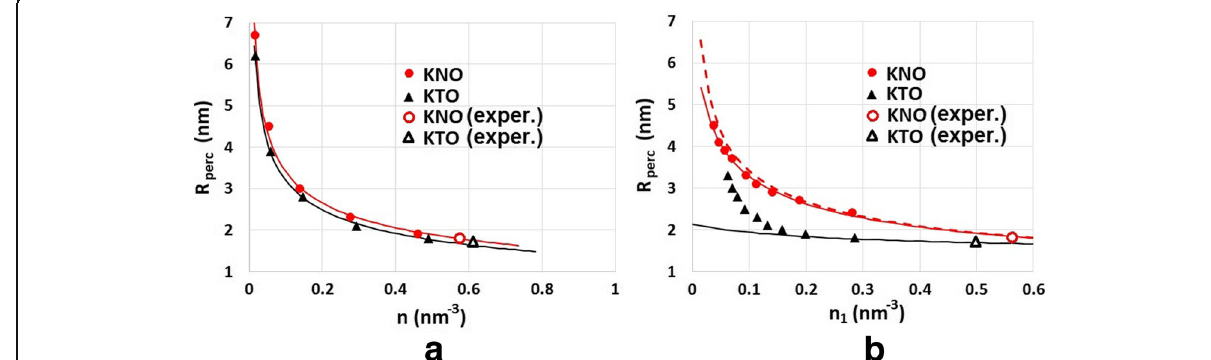
Fig. 9 Percolation radius versus the concentration of defects for two cases: a n 1 / n 2 =const, n varies and b n 2 =const, n 1 varies. Points are calculated numerically in the framework of our model, solid curves are based on the formula (1). Points marked with labels correspond to the studied materials (KTaO 3 and KNbO 3 )